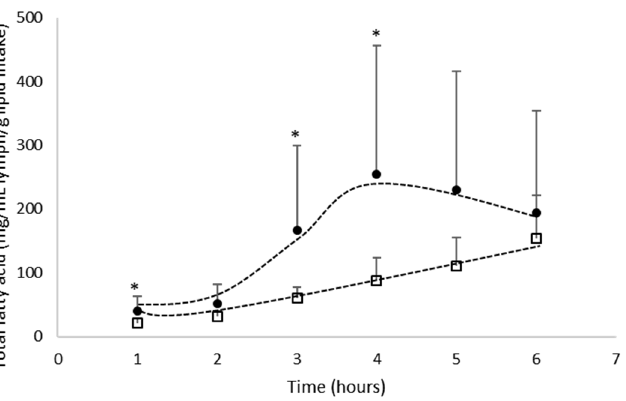
Figure 2. Kinetics of intestinal absorption of fatty acids (mg/mL lymph/g of lipid intake) in rats submitted to a lymphatic duct’s fistula ( n = 8 rats/group) and orally supplied with 200 mg of lipids from an oil either in bulk phase ( (cid:3) ) or emulsified with gum acacia ( • ) over a 6 h period. Data are presented as their means ± standard deviation *. For the same time period, data are significantly different between the two groups ( p < 0.05; Student’s t -test). Table 4. Summary data for the maximal concentration (Cmax; mg/mL), area under the curve (AUC; mg/mL.h) and Tmax (h) for lymphatic main fatty acids in animals submitted to unemulsified versus emulsified oil.